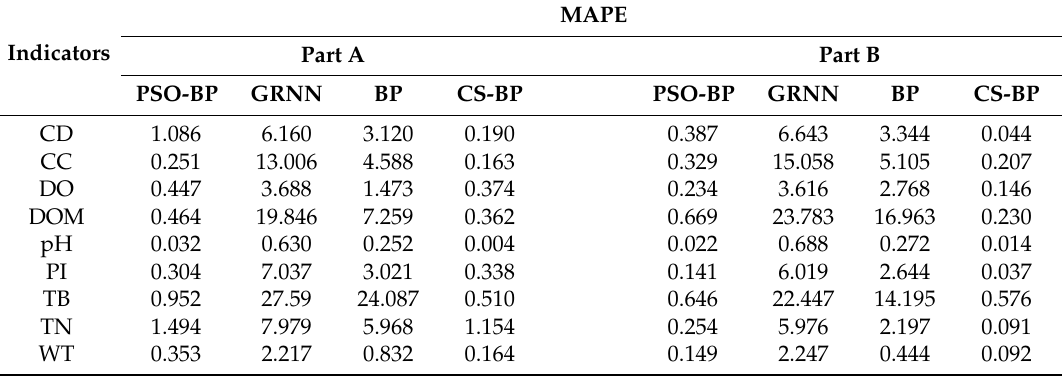
Table 8. The MAPE of water quality indicators of four models in different data proportions in Scenario